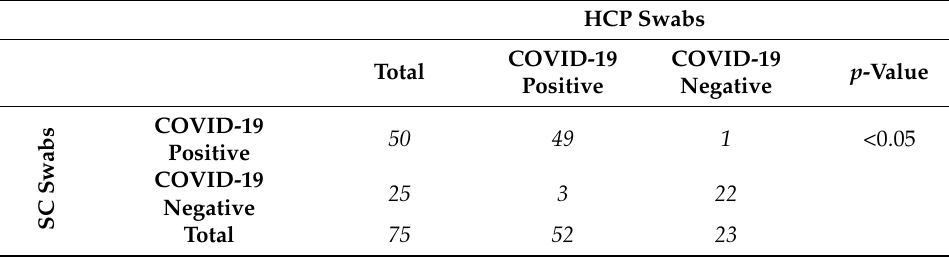
Table 1. Statistical correlation between the SC Swab and the standard diagnostic HCP